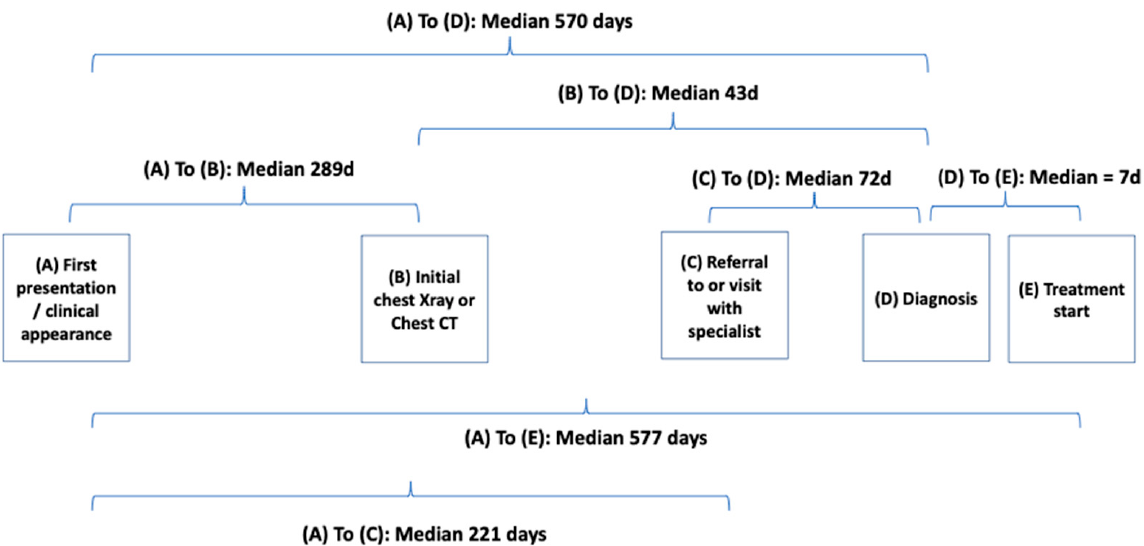
Figure 3. Duration of time intervals from first symptomatic presentation to diagnosis and initiation of treatment. Visualization of time intervals by stage of lung cancer (Figure 4) indicates longer median time interval A to D for early than late-stage cancer (639 vs. 540 days), including markedly longer intervals B to D (100 vs. 23 days) and C to D (244 vs.